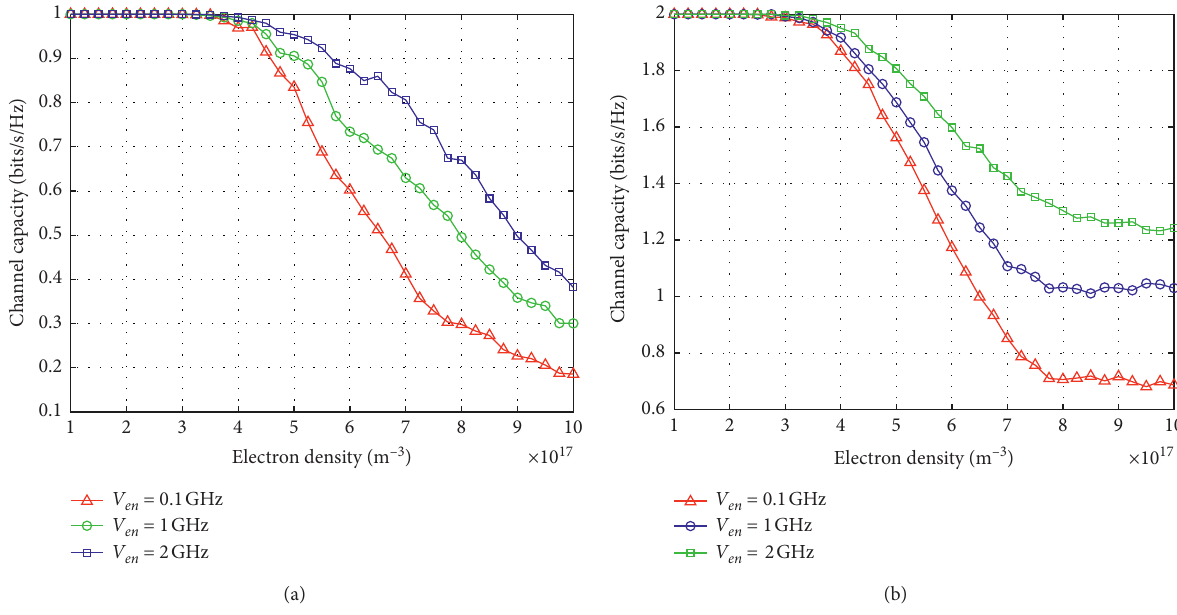
Figure 6: Influence of v